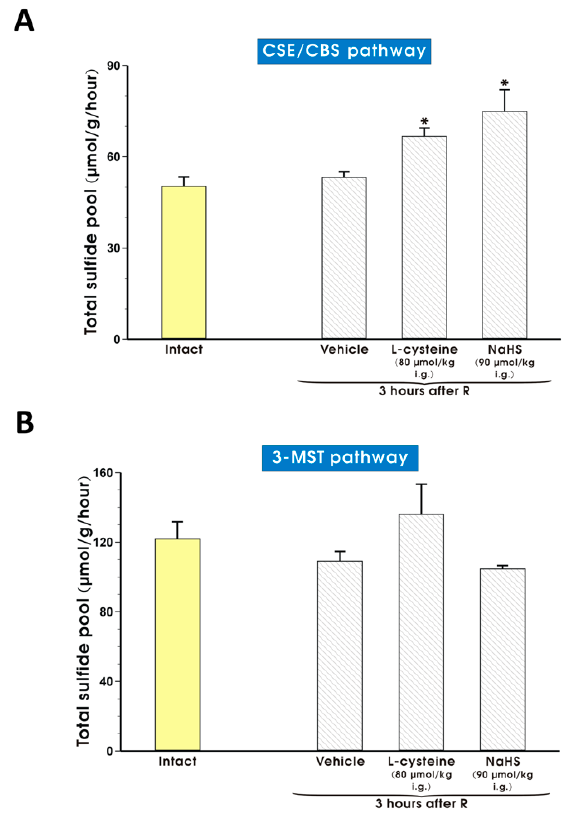
Figure 10. Total sulfide pool released by activity of CSE/CBS ( A ) or 3-MST ( B ) pathway from gastric mucosa of intact rats and those pretreated with vehicle (saline), L -cysteine (80 µ mol/kg i.g.) or NaHS (90 µ mol/kg i.g.) and exposed to I followed by 3 h of R. Results are mean ± S.E.M of 4–5 rats per each experimental group. Asterisk indicates a significant change as compared with the value obtained in intact rats ( p < 0.05).